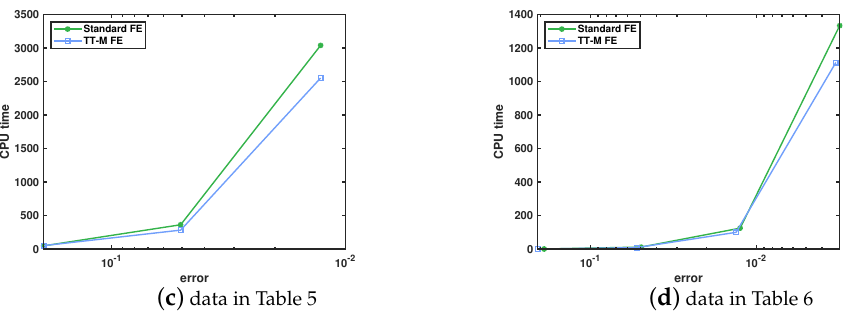
Figure 8. Comparison for the computing time between the TT-M FE method and the standard FE method based on the data in Tables 3–6. Table 4. Space-time convergence results for Example 2 in Case 1 with τ = 1